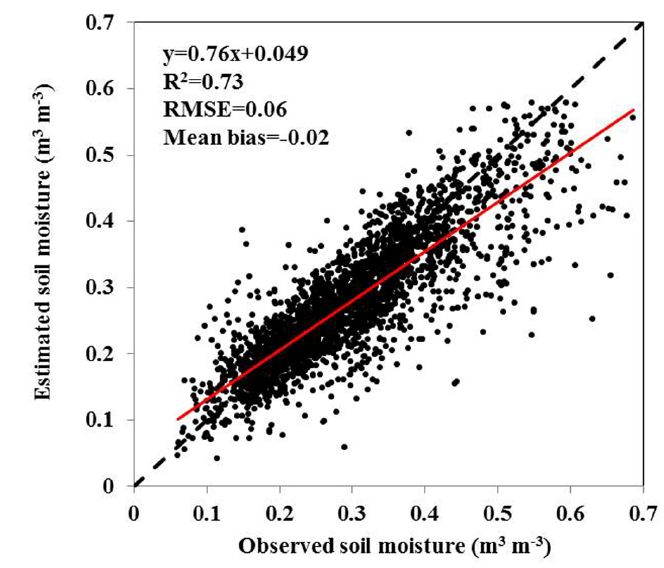
Figure 4. Comparison of estimated surface soil moisture against observed ones at each observation site.